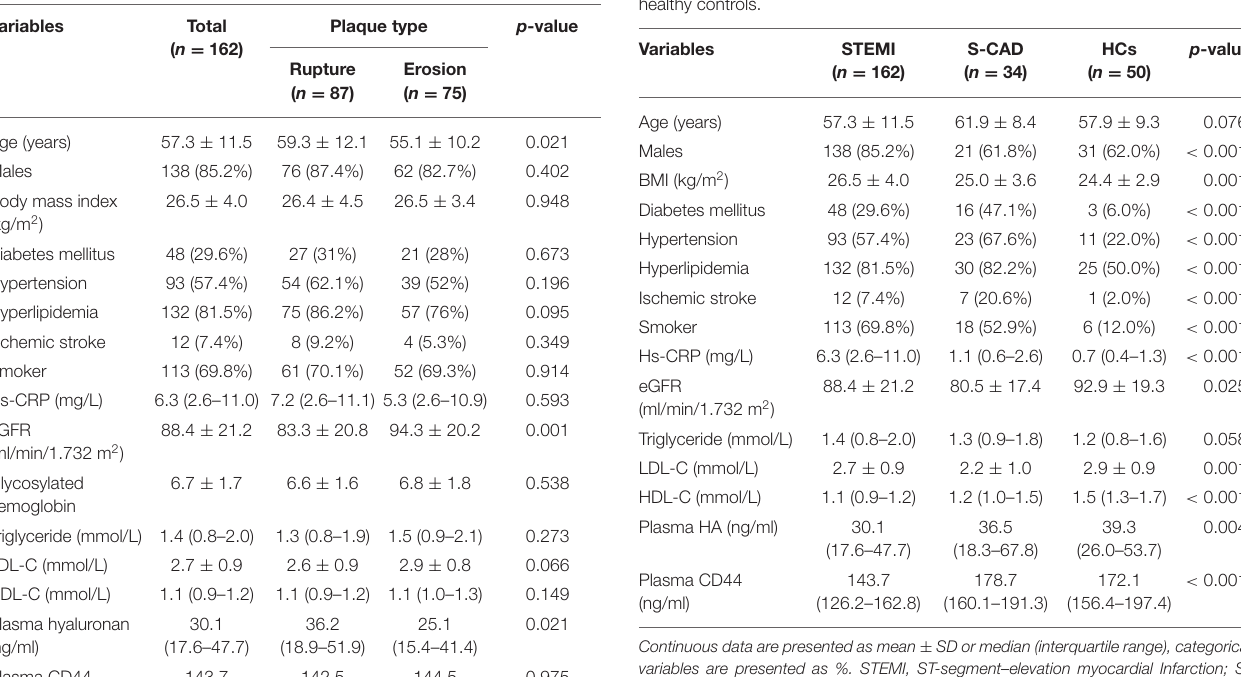
TABLE 1 | Baseline characteristics of subjects stratified by plaque types. TABLE 2 | Baseline characteristics of subjects among STMEI, S-CAD and